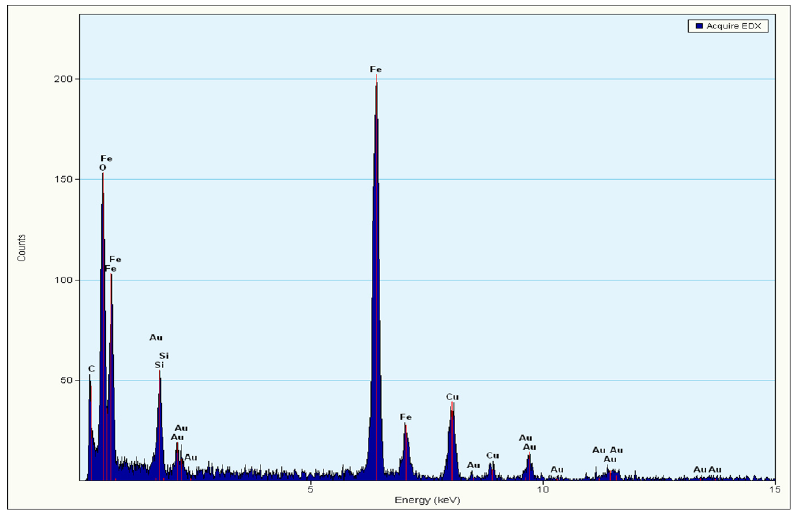
Figure 3. Energy dispersive X-ray (EDX) spectrum of Fe 3 O 4 /Au gold magnetic nanoparticles.